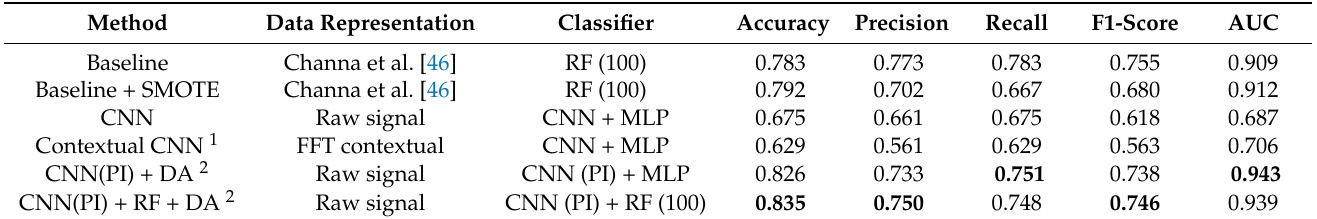
Table 3. Results of different bradykinesia detection methods using data collected for a single triaxial gyroscope. SMOTE: synthetic minority over-sampling technique; RF: random forest; CNN: